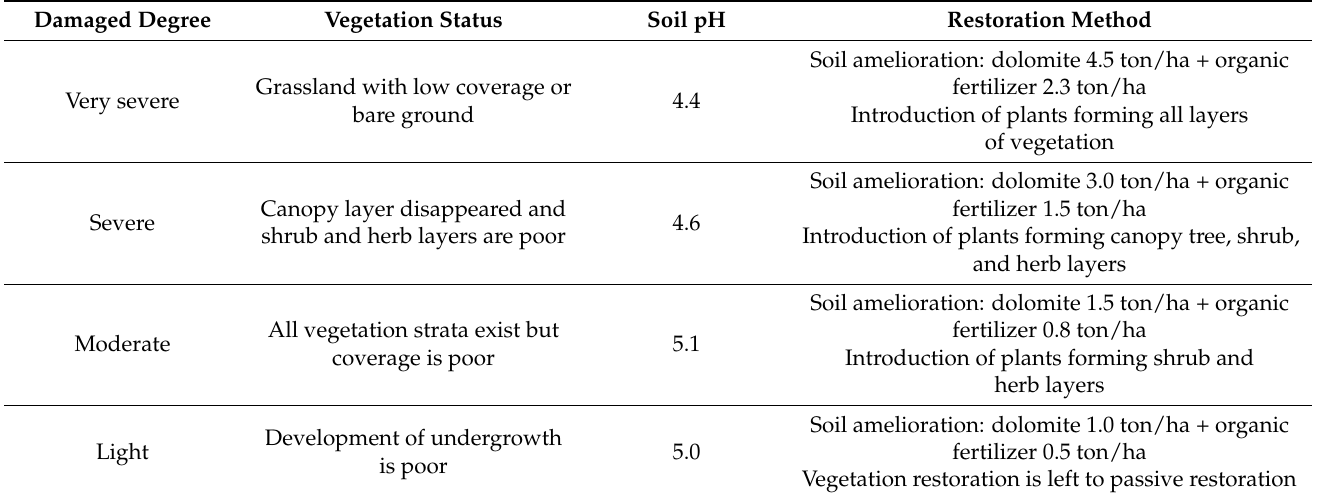
Table 5. Level and method of restoration recommended based on a diagnostic evaluation of the forest ecosystem around Seokpo zinc smelter, central eastern